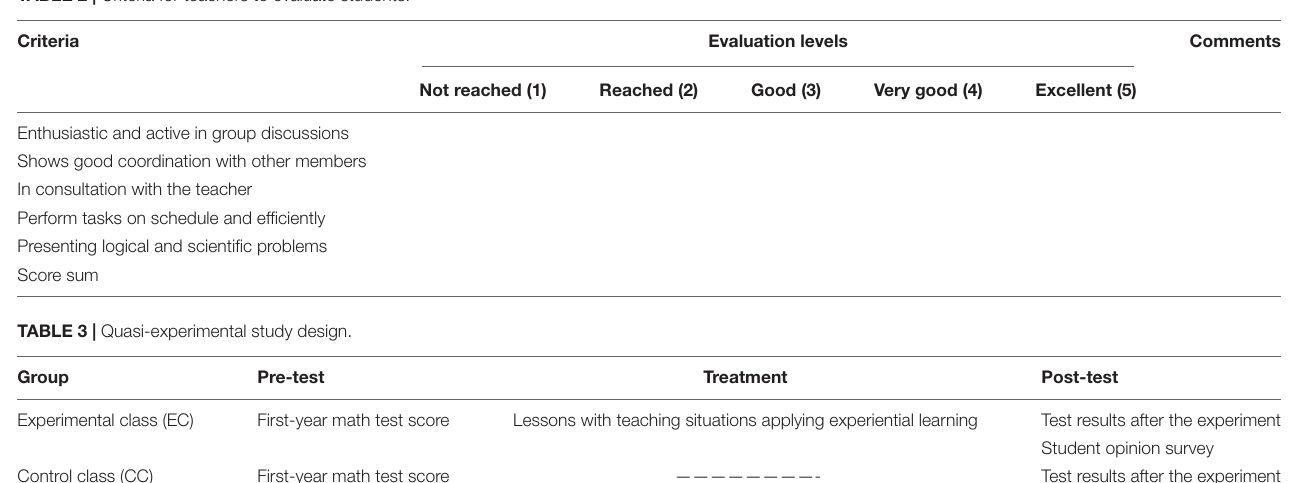
TABLE 2 | Criteria for teachers to evaluate students.